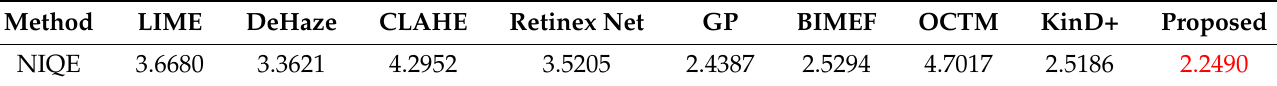
Figure 11. The enhancement results obtained for real images. They are the criteria for the experiments in Figure 10. Table 2. Average NIQE. The best data is marked in